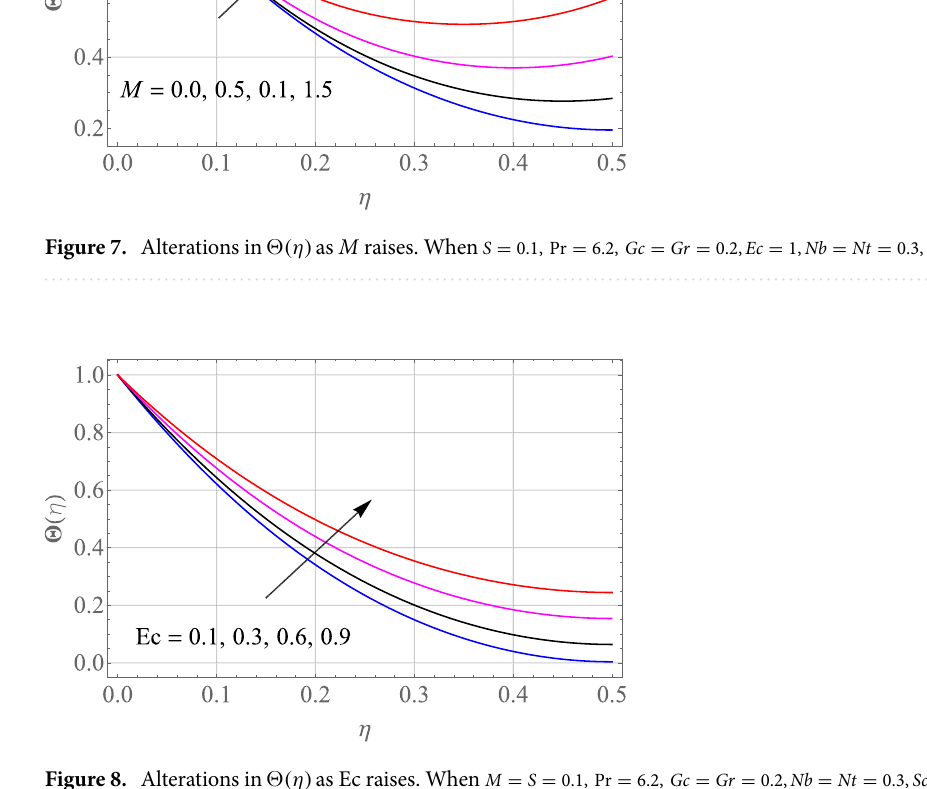
causing heat to be produced and, as a result, temperature of liquid and the resulting boundary-layer thickness to thicken. The effect of different values of Ec on thin film nanofluid �(η) temperature profiles is depicted in Fig. 8. It’s easy to see how growing Ec magnitude, improves the �(η) in the boundary layer. As Ec is increased, a bump appears near the layer, and the nanofluid temperature then moves to the atmospheric temperature value far from the surface. Basically, the kinetic energy to enthalpy ratio is called the Ec. Figure 9 depicts the effect of Pr on the �(η) (Temperature distribution) of liquid films. The opposite finding on the �(η) against the Pr can